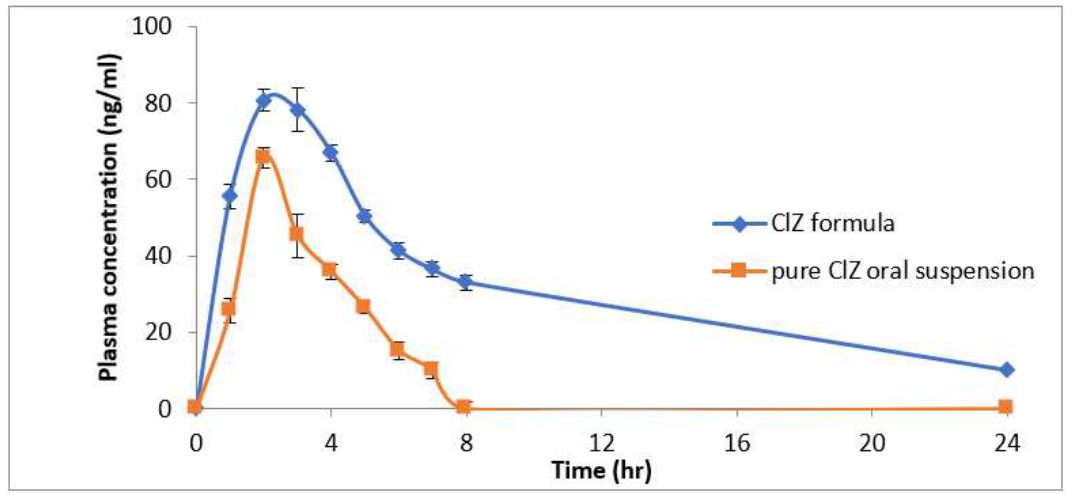
Figure 12. Plasma conc. versus time profile of CLZ after administration of buccal lozenges compared with oral drug suspension in rats .